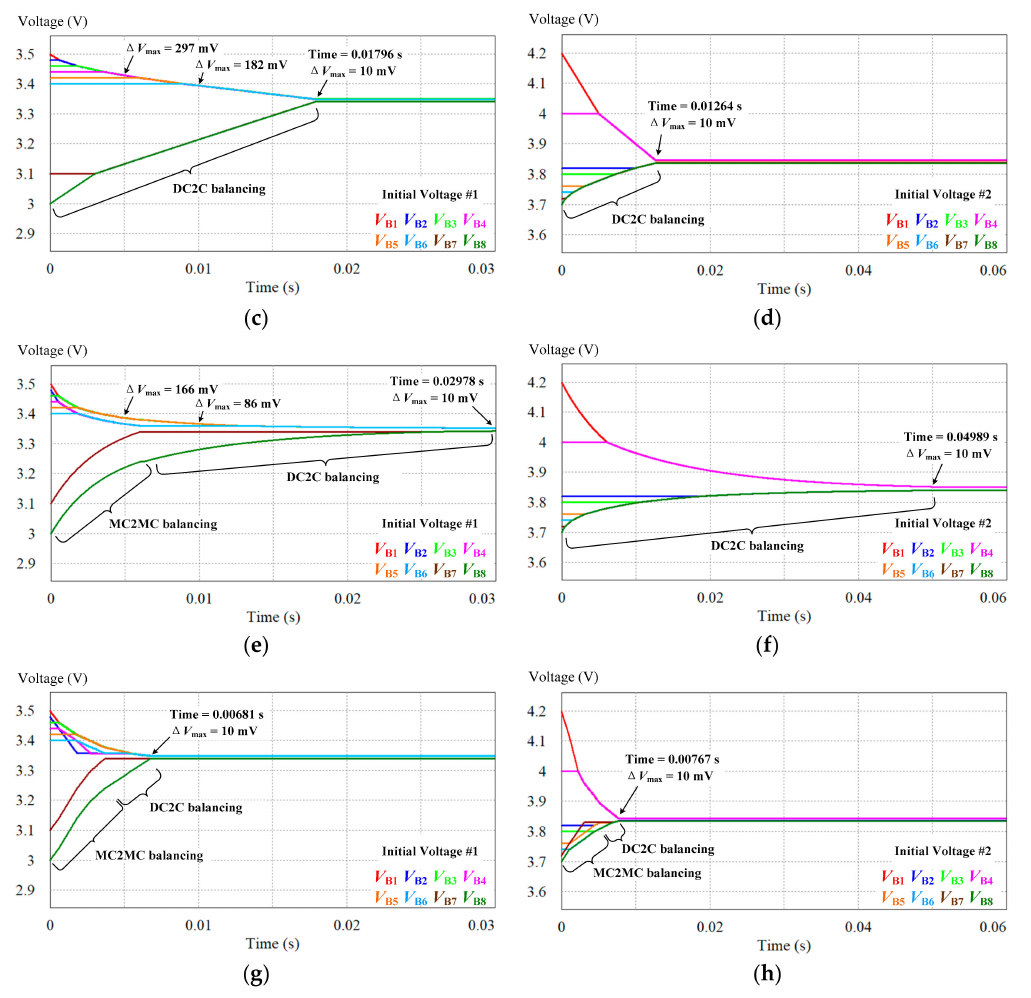
Figure 12. Voltage trajectories of different equalizers with initial voltages #1 and #2. ( a , b ) AC2C equalizer based on QRSCC. ( c , d ) DC2C equalizer based on LCSRC. ( e , f ) MC2MC equalizer based on HBLCC. ( g , h ) Proposed MC2MC equalizer based on